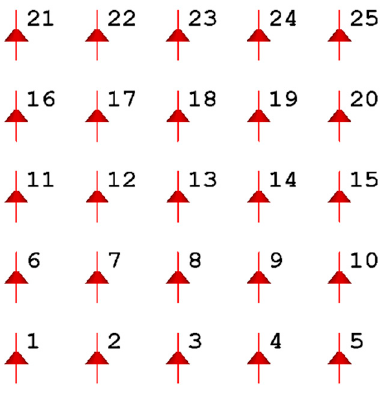
Figure 7. Square Figure 7. Square array. Figure 7. Square array.